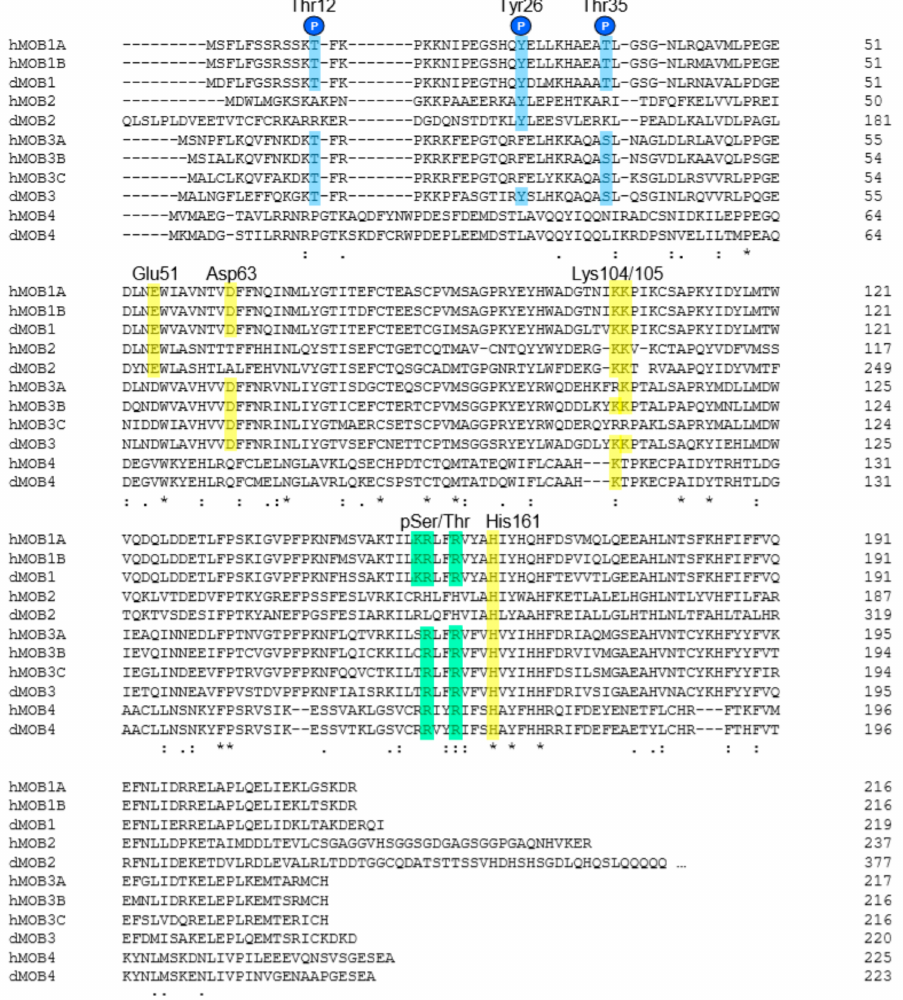
Figure 3. Comparison of the primary protein sequences of human and fly MOBs. Primary protein sequences were aligned using Clustal Omega as defined in the legend of Figure 2. The sites of Thr12, Tyr26 and Thr35 phosphorylations of hMOB1A are highlighted in light blue. Important interaction sites of hMOB1A that were verified by di ff erent experimental approaches are displayed in